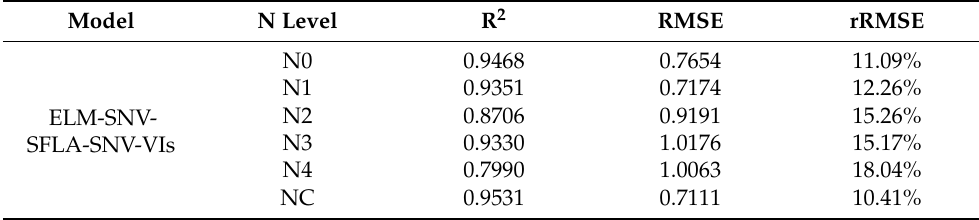
Table 10. Cotton LAI monitoring verification results of different N concentrations in the opti- mal